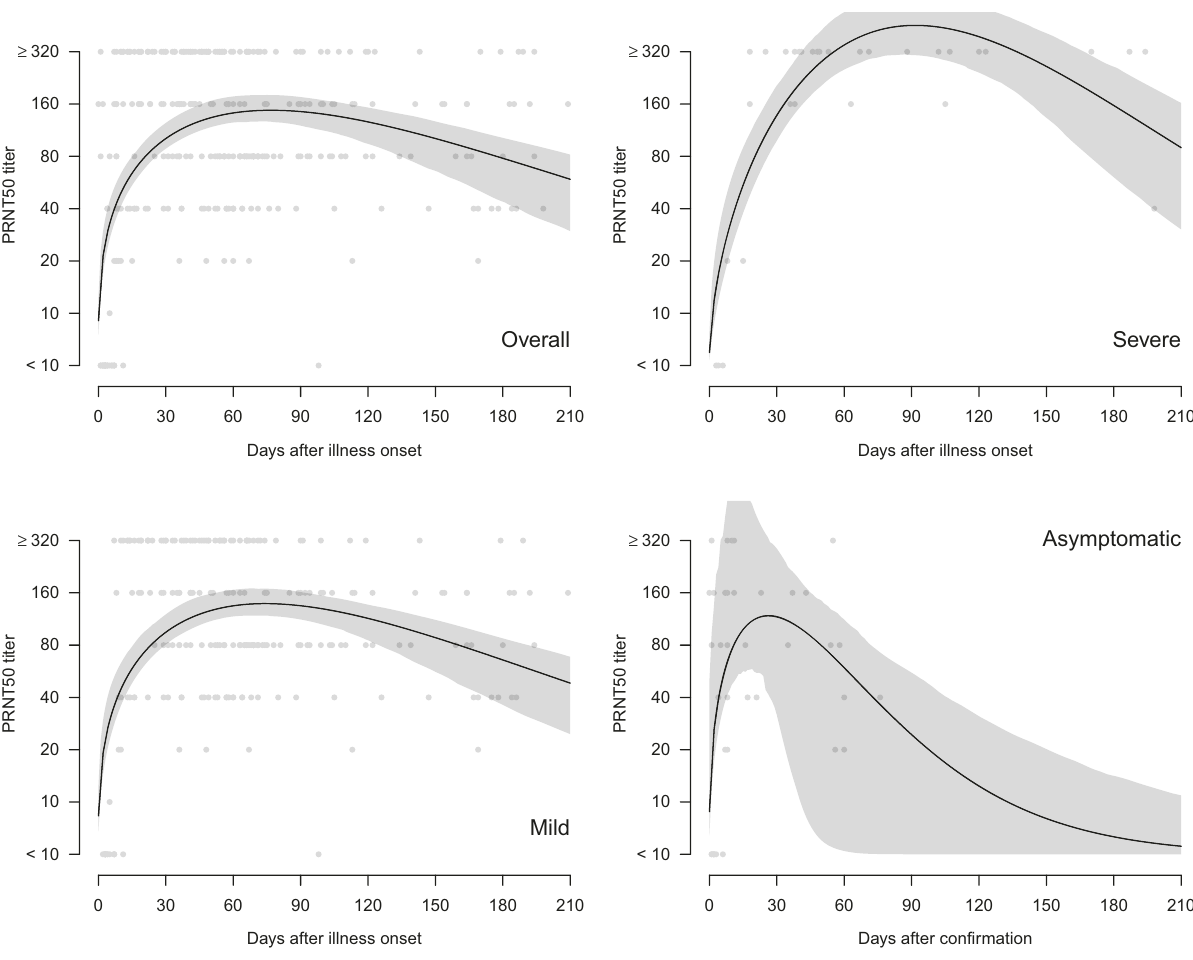
disease. Plaque reduction neutralization tests are the “ gold-stan- dard ” for assessing neutralizing antibody titers with 50% reduc- tion of plaque numbers (PRNT 50 ) being an established end-point for assessing the serum neutralizing titre. We have determined